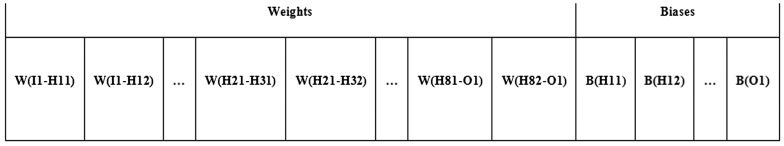
Defined chromosome structure for coding the unknown neural network parameters (weights and biases are represented by W and B, respectively).